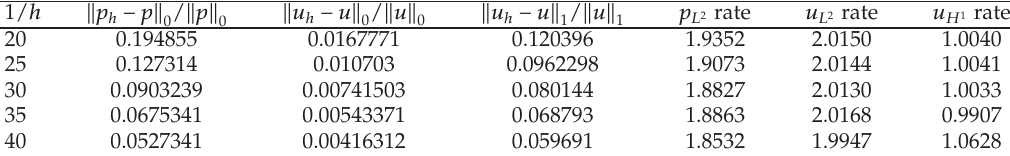
Table 3: Numerical results for SGM with P 1 b - P 1 element.